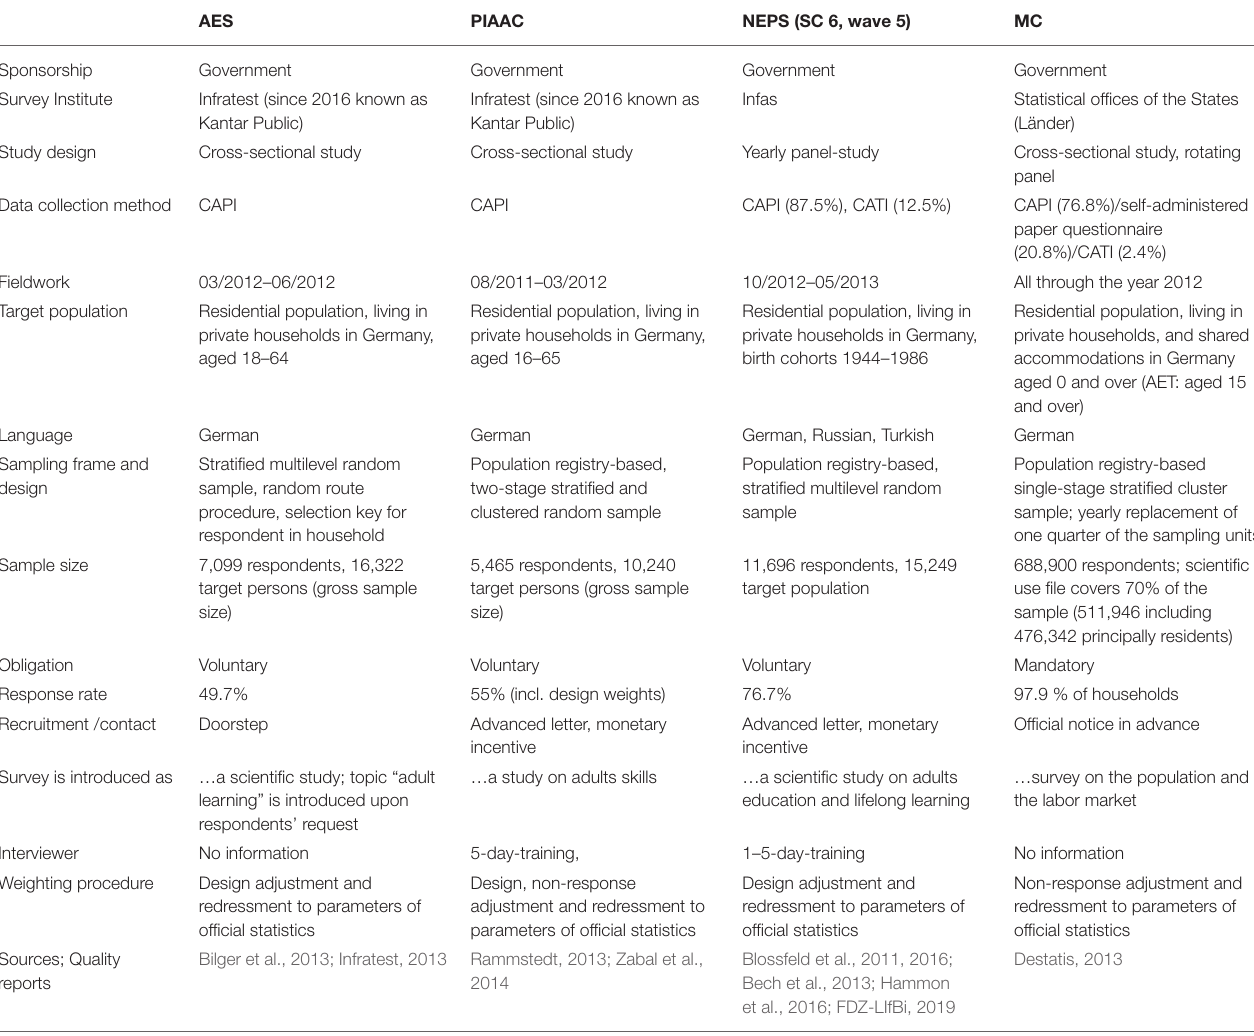
TABLE 1 | Overview of survey design of AES, PIAAC, NEPS, and